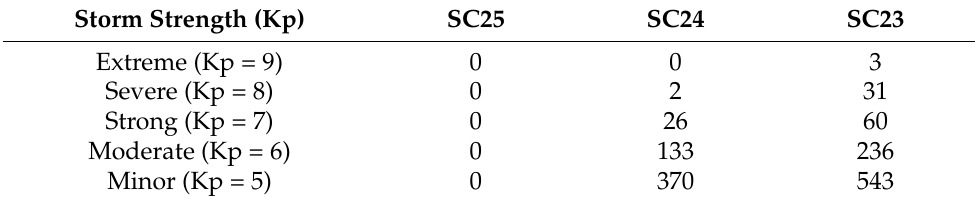
Table 1. Geomagnetic storms classification based on the Kp index. Storm Strength (Kp) SC25